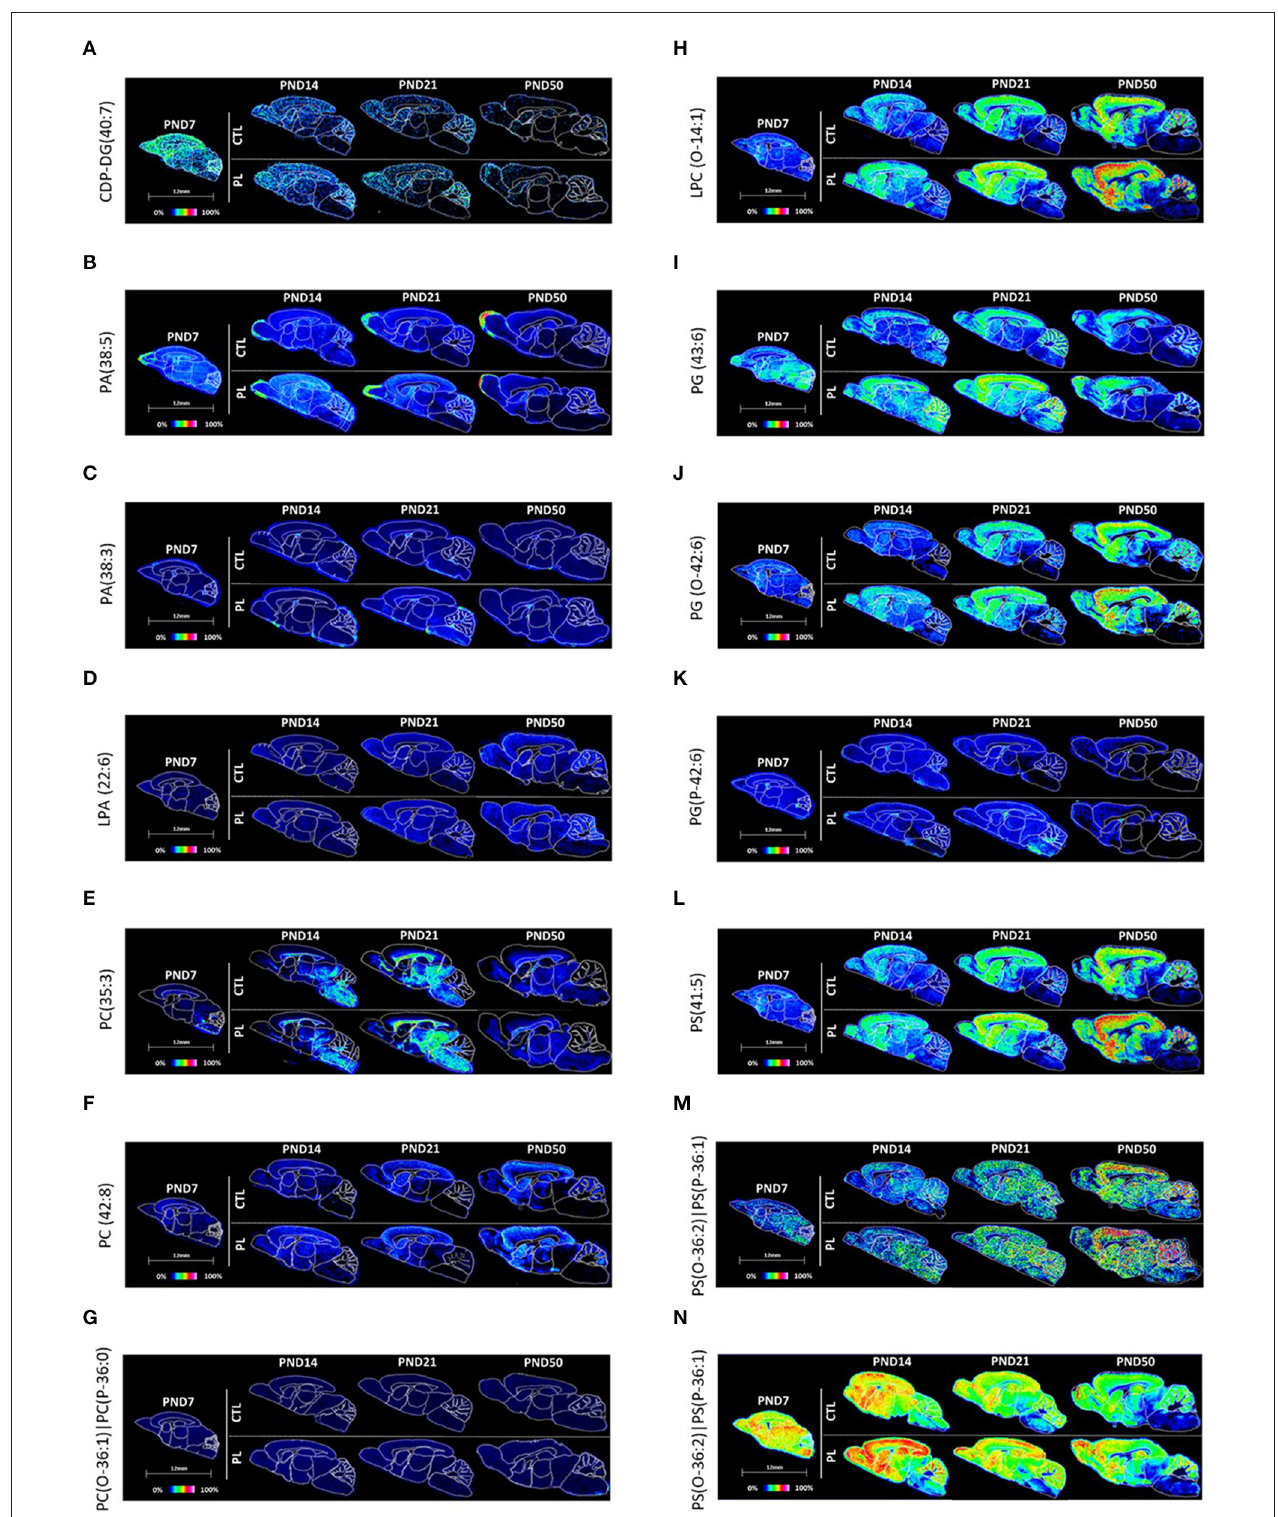
FIGURE 6 | Spatiotemporal distribution of glycerophospholipids. Representative MALDI-MSI images are shown for (A) CDP-DG, (B–D) glycerophosphates, (E–H) glycerophosphocholines, (I–K) glycerophosphoglycerols, and (L–N) glycerophosphoserines. Control sections are presented on the top. PL-supplemented sections are presented on the bottom. The age is indicated above the images. The signal intensity scale is normalized to 100% of maximum peak intensity across all images.